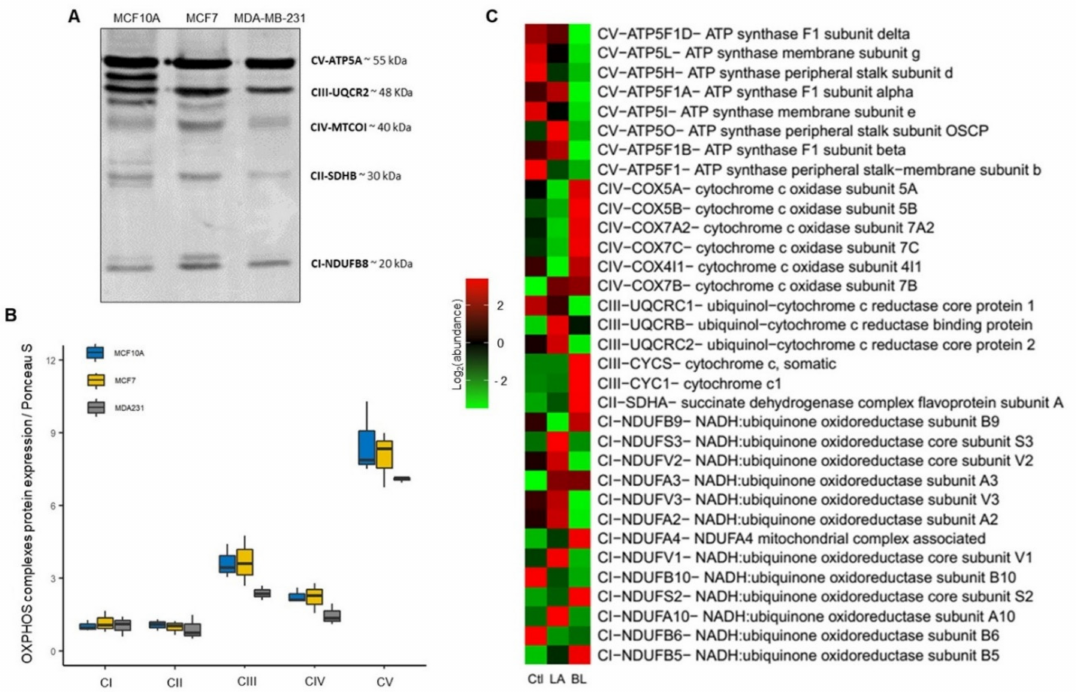
Figure 10. OXPHOS protein expression profiles in luminal A and basal-like subtypes of breast cancer. ( A , B ) Western blotting and expression of total oxidative phosphorylation (OXPHOS) cocktail in MCF10A, MCF7 and MDA-MB-231 cell lines. Densitometry values were normalized by Ponceau red staining. The data are presented as mean ± SD, n = 3. ( C ) Proteins expression profiles of OXPHOS complexes in control samples, luminal A, basal-like breast cancer